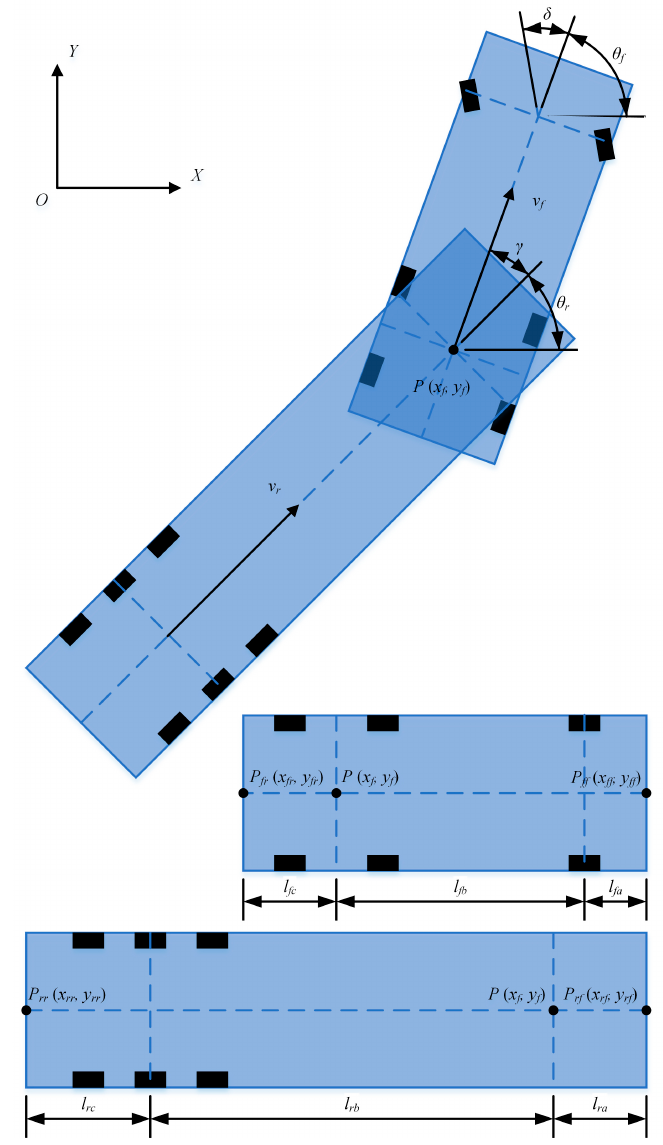
Figure 1. The kinematics model of the semi-trailer.